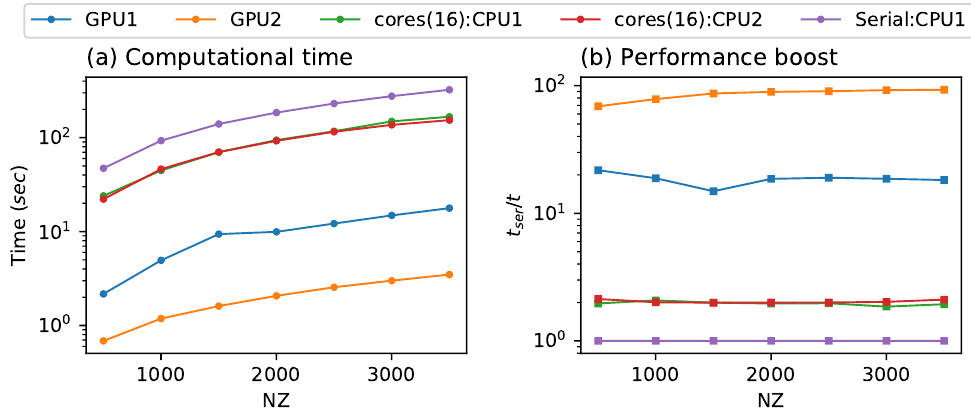
Figure 19. Comparison of computational time and performance for variation of spatial grid size along Z direction NZ keeping spatial grid size along X direction and temporal grid constant ( NX = 201, NT = 1000) in forward simulations.